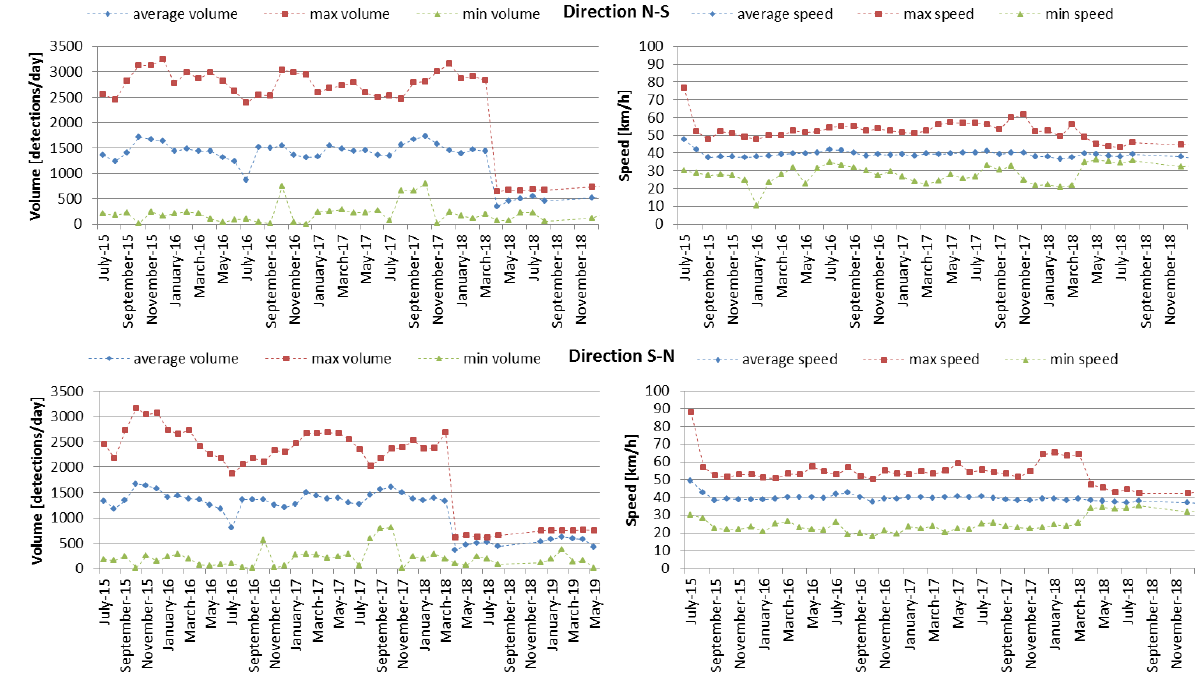
Figure 14: Number of detections and average speed for Route 1 in both